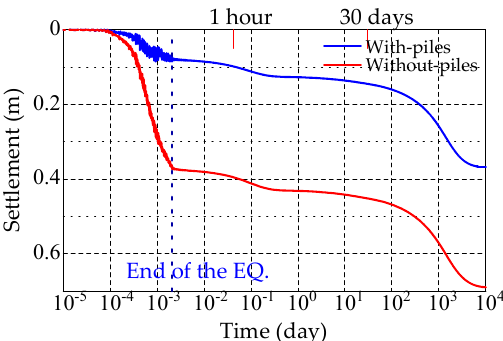
Figure 16. Comparison of settlement behavior during and after earthquake between with and without piles: seismic motion (A).